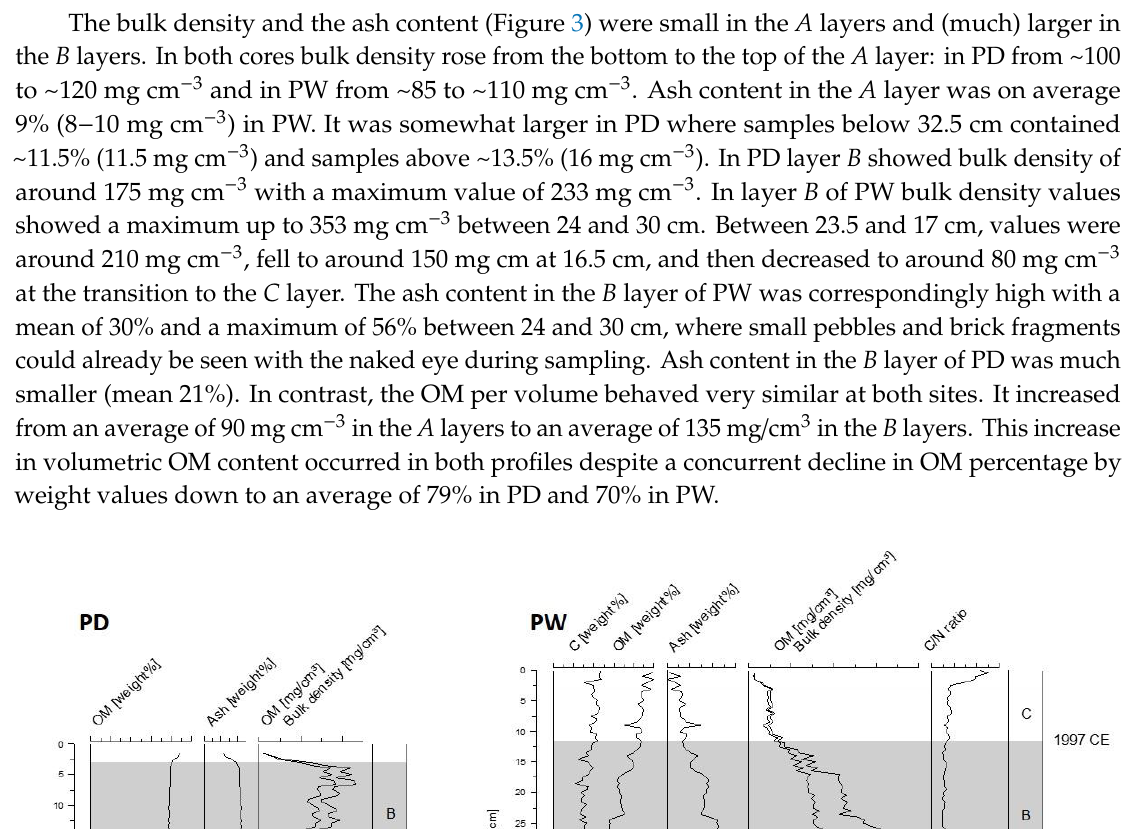
Table 1. Data for calculation of losses at PD and PW .